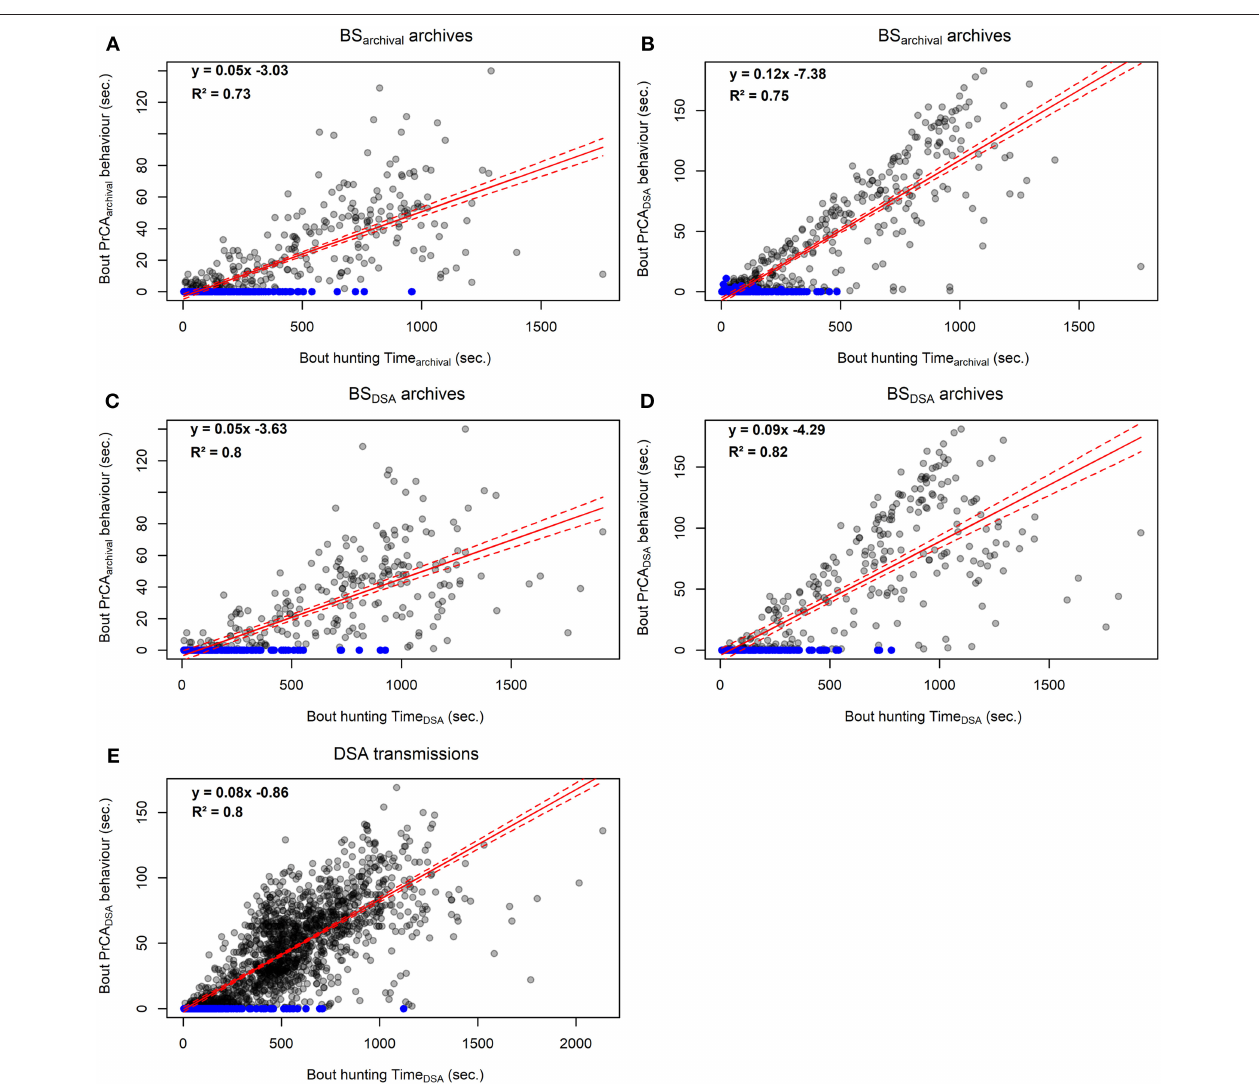
FIGURE 4 | Comparison between foraging bout durations and time spent in PrCA behaviors estimated from high-resolution acceleration archives from established procedures (#143468; A and C ) and simplified DSA algorithms (#143468, B and D ; n = 4, E ). The red line represents the intercept-slope output, with 95% confidence intervals in dashed red. Blue dots indicate hunting bouts during which there was no time spent in PrCA behaviors.